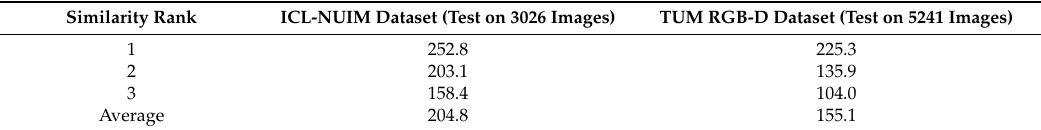
Table 3. The average number of ORB Oriented FAST and Rotated BRIEF) good-match in two